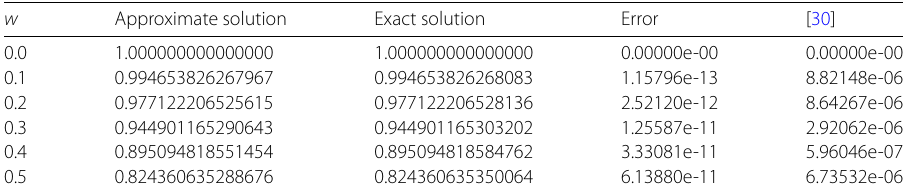
Table 1 Comparison of approximate and exact solution and absolute error of Example 5.1 when J = 4 w Approximate solution Exact solution Error [30] 0.0 1.000000000000000